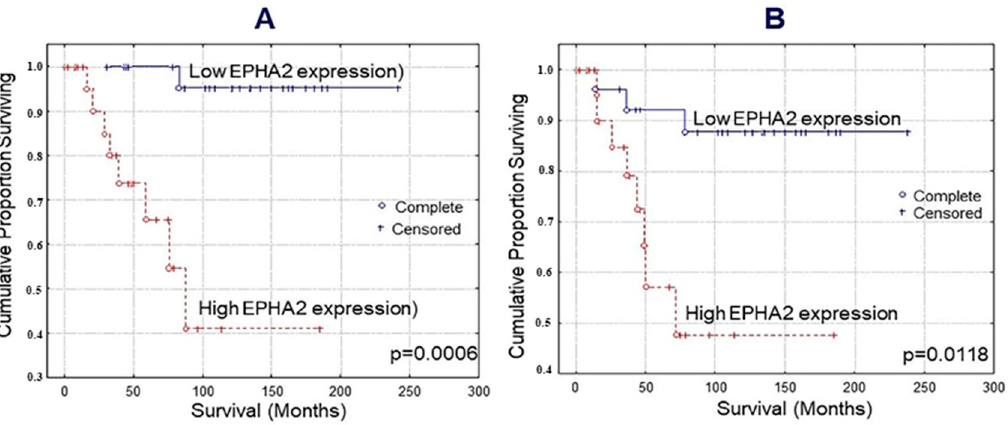
Table 5. Multivariate analysis for histologic type, grade, tumor size, lymph node status, Ki-67 status, and EPHA2 expression for DFS.